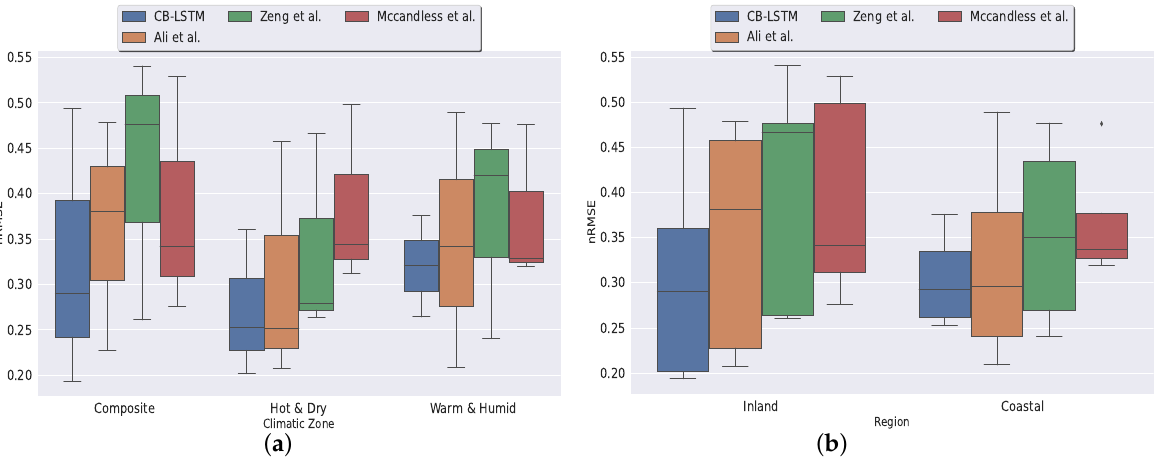
Figure 12. ( a ) Climatic-zone-specific variability in predictions; ( b ) region-specific variability in predictions. The symbol “†” indicates an outlier.